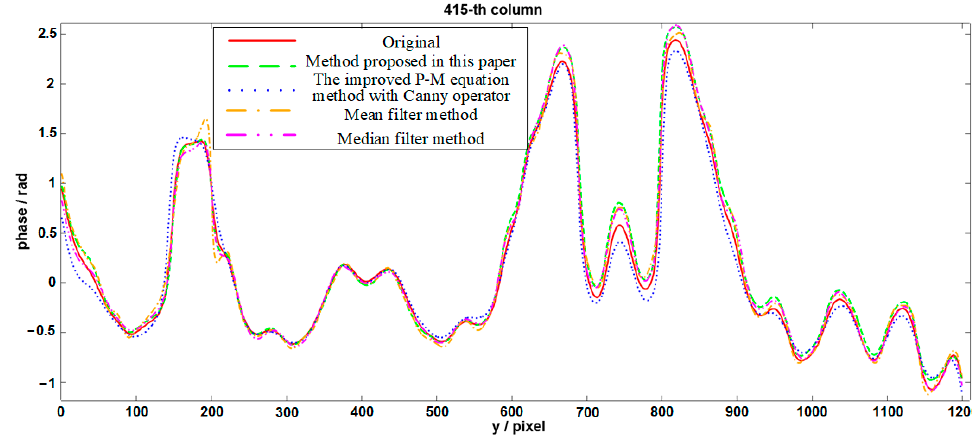
Figure 9. The cross-section curve at x = 415 of the phase maps shown in Figure 7a–d and the original phase map.